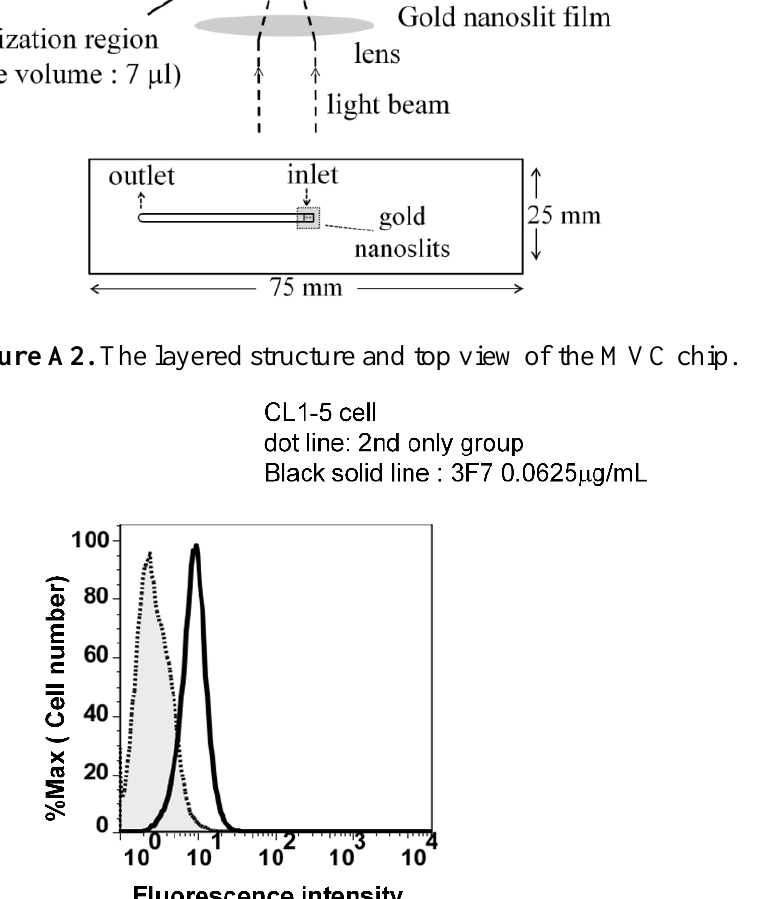
Figure A3. The binding potency analysis of anti-EphA2 Mabs on CL1-5 cell by flow cytometry. Mouse anti human EphA2 antibodies (3F7) was used to detect EphA2 on CL1-5 cells. The cells were harvested from the tissue-cultured flask with versene (EDTA-PBS) and washed with ice cold 1% FBS/PBS. The cells were incubated with antibody (0.0625 mg/ 3 × 10 5 cells) for 30 min on ice and washed with 1% FBS/PB. The cells were incubated with FITC-conjugated donkey anti-mouse IgG antibody (0.2 mg/3 × 10 5 cells) for another 30 min on ice and washed with 1% FBS/PBS. The fluorescence intensity was determined by BD FACSCalibur (BD Biosciences). Data were analyzed by software FlowJo 7.51. The result of the flow cytometry analysis shows antibody3F7 has the high affinity to bind with EphA2 on CL1-5